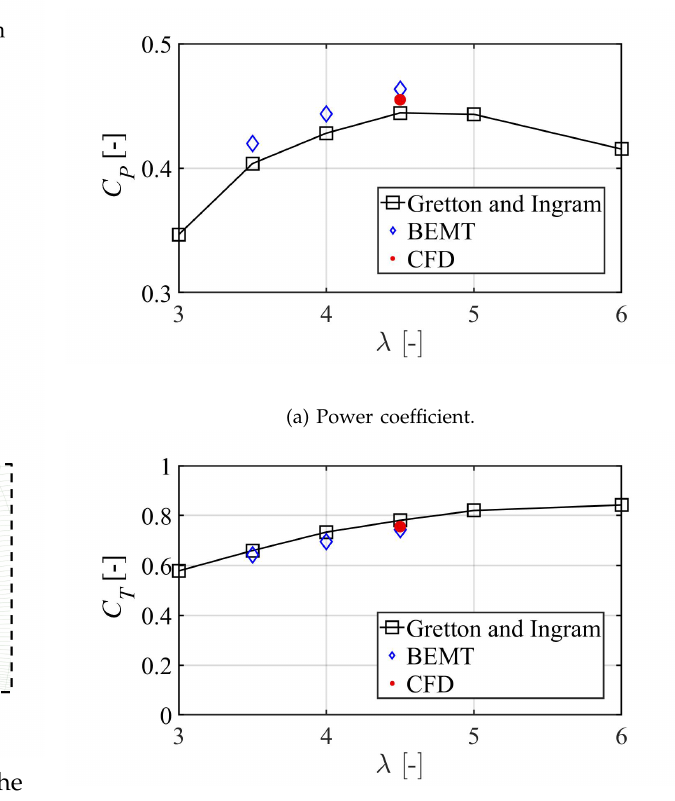
Fig. 9: Numerical setup of the CFD simulations of the rotor: (a) computational domain and boundary condi- tions; (b) surface grid of the rotor; (c) surface grid at the hub-rotor interface; (d) grid around a thick section of the blade near the root, and (e) around a thin section near the tip.